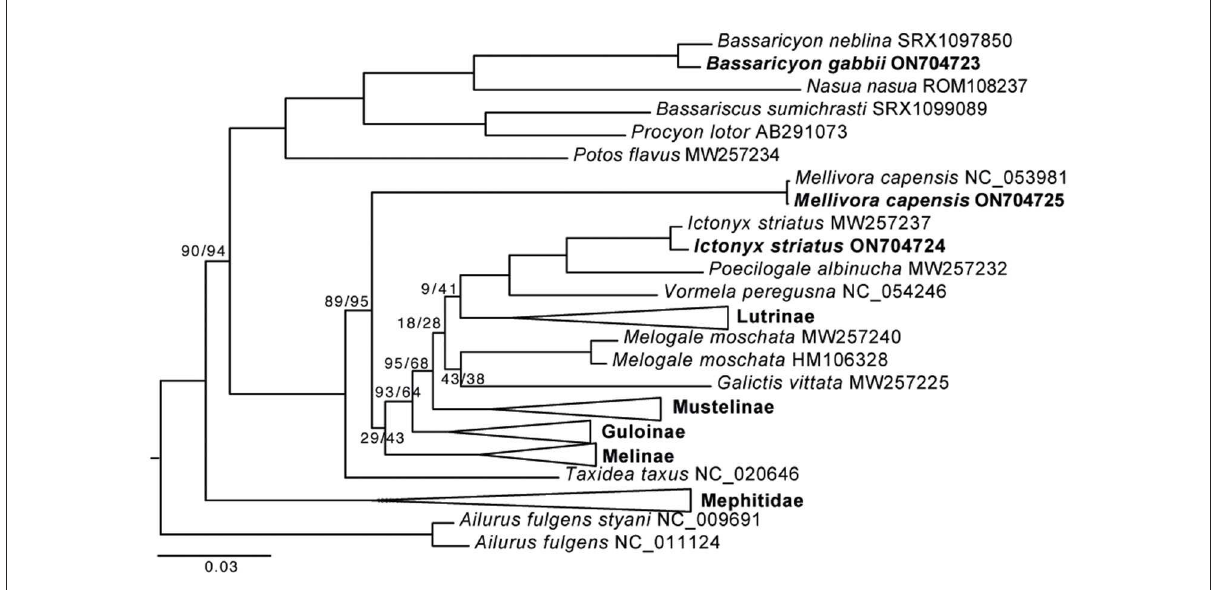
Supplementary Figure 2. Pinnipedia was used as outgroup (pruned from the tree). GenBank accession numbers are shown in Supplementary Table 2. All nodes without a value were supported by ≥ 99% UF bootstrap support. Values at each node represent SH-aLRT/UFBoot support in %. The scale bar indicates nucleotide substitutions per codon